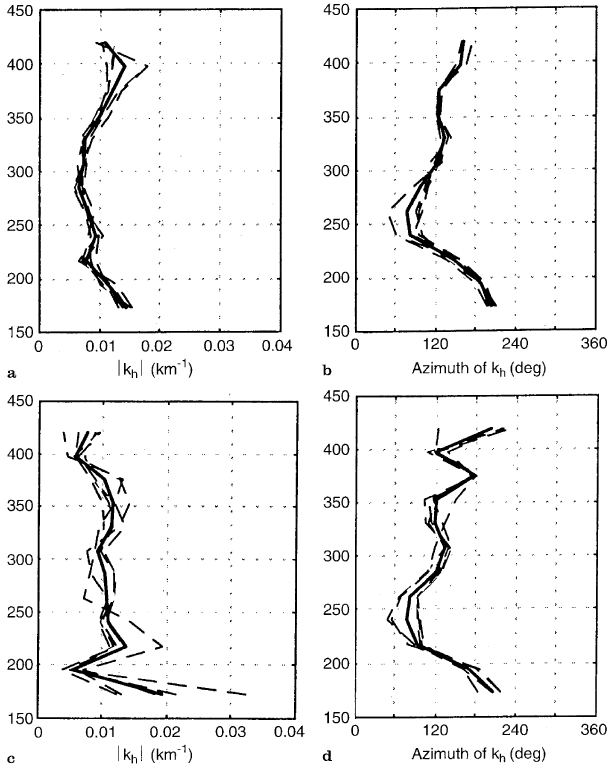
Fig. 5. Magnitude ( left column ) and azimuth ( right column ) of the apparent horizontal wave number, k h , versus altitude of the N e -TID ( top row ) and the T e -TID ( bottom row ) with a period of 72min. The dashed lines denote the k h profiles derived from 5 combinations of the 4 di(cid:128)erent probing positions. The thick solid lines represent the